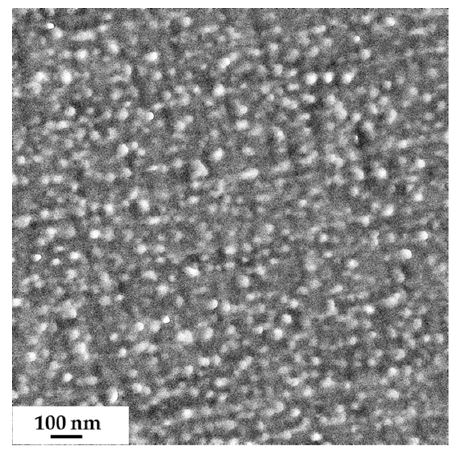
Figure 4. TEM image of an ultra-thin section of PS 81 - b -PGMA 19128 , film cast from 5 wt % diblock copolymer in DMF; the diameter of the brighter spheres is approximately 30–35 nm.